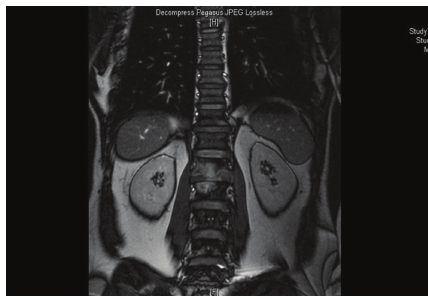
Figure 3: Magnetic resonance imaging of pathologic signalization in lumbar